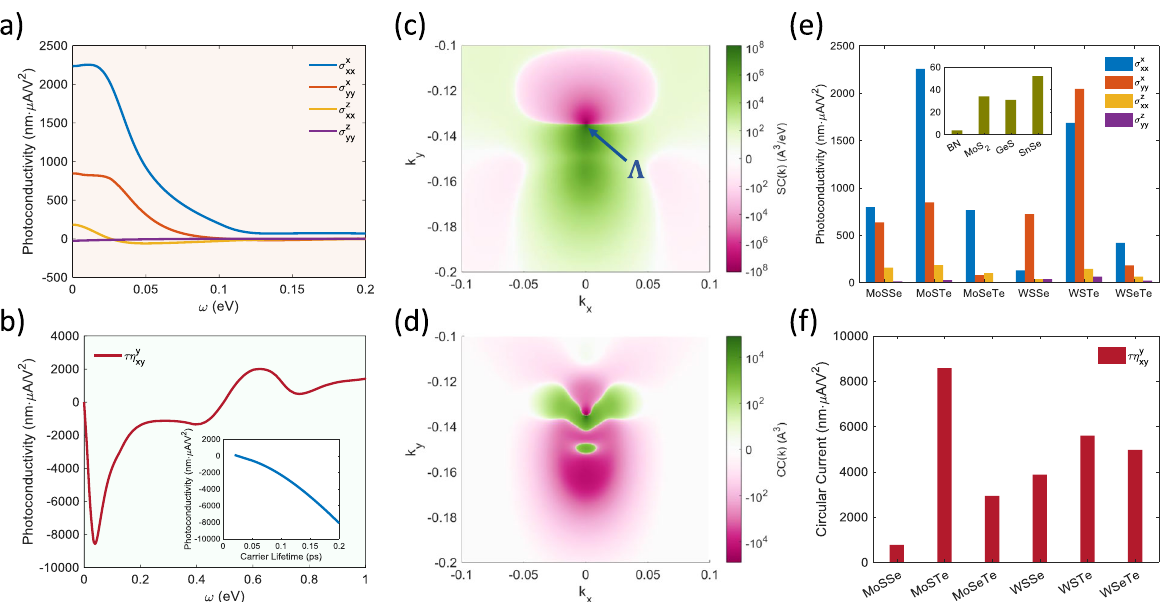
Fig. 4 Nonlinear photoconductivities of MoSTe. a The SC conductivity σ c ab ð 0 ; ω ; (cid:2) ω Þ of MoSTe. b The CC conductivity τη c ab ð 0 ; ω ; (cid:2) ω Þ of MoSTe. Inset: the magnitude of the fi rst peak of CC conductivity as a function of carrier lifetime τ . c , d The k -speci fi ed contribution to σ x xx and η y xy . c shows SC( k ) at ω = 10 meV while d shows CC( k ) at ω = 50 meV. The color maps are in logarithmic scale. k reciprocal lattices. e , f The peak values of the SC ( e ) and CC ( f ) conductivities of six MXY. Inset of e : the peak values of SC conductivities of several other 2D materials, including hBN, 2H MoS 2 , GeS, and